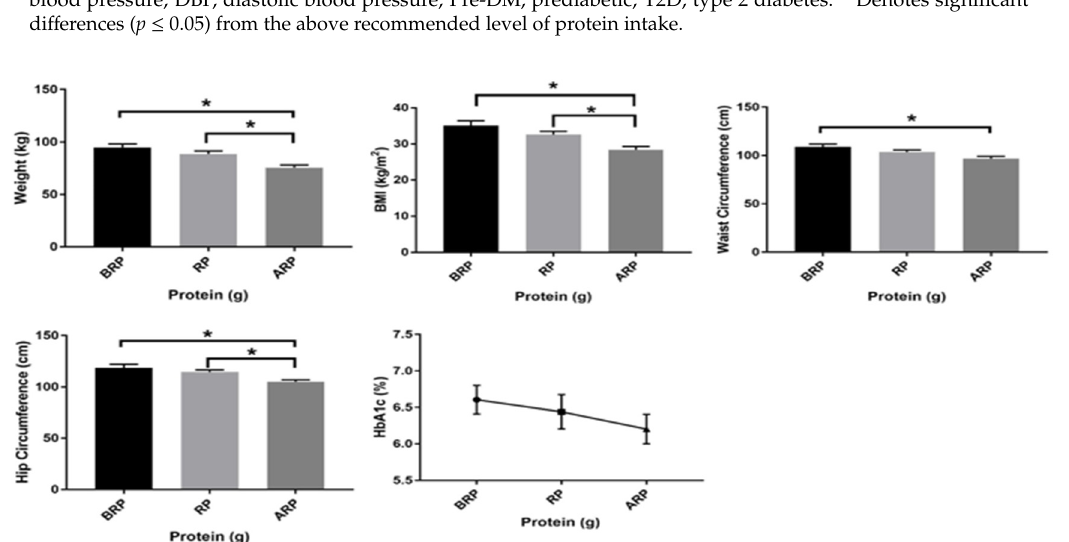
Figure 2. Among group di ff erences in weight, body mass index (BMI), waist circumference, hip circumference, and hemoglobin A1c (HbA1c) of study participants below ( n = 17), meeting ( n = 22), and above ( n = 23) the recommended-protein groups (below the recommended-protein group (BRP), the recommended-protein group (RP), and the above recommended-protein group (ARP), respectively). Values are reported as mean ± standard error of the mean (SEM). * Denotes significant di ff erences among groups ( p ≤